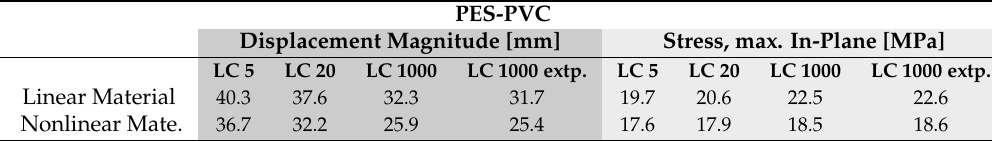
Table 9. The obtained maximum displacement and in-plane Cauchy stress values in simulation of the roof structure. The material is the PES-PVC III with adjusted and extrapolated